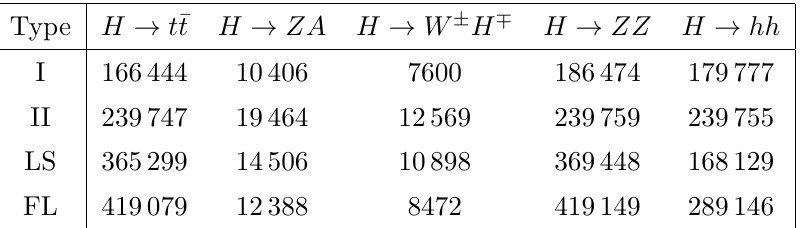
Table 8 . Number of parameter points available for the analysis in the individual OS decay channels of H ( h is